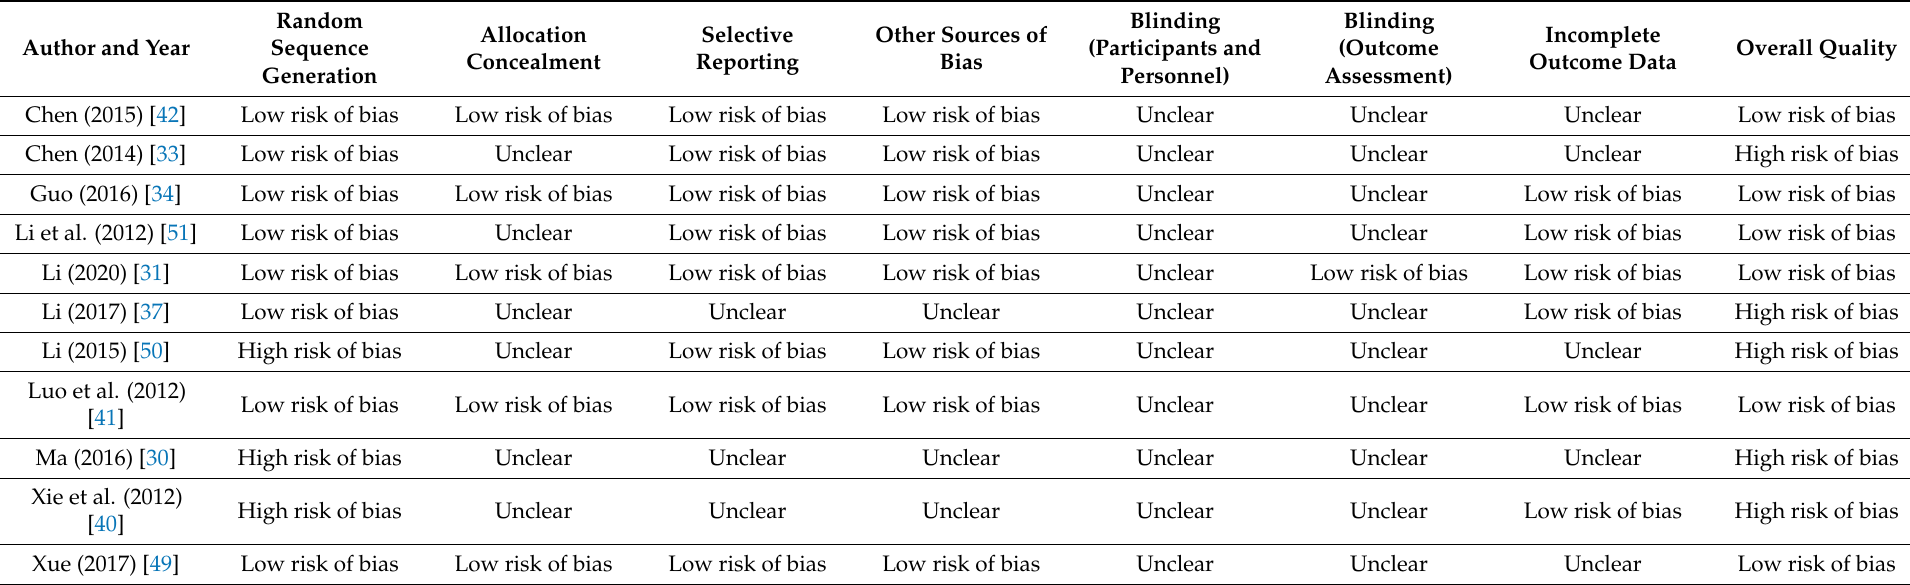
Table 3. The Quality Assessment of Intervention